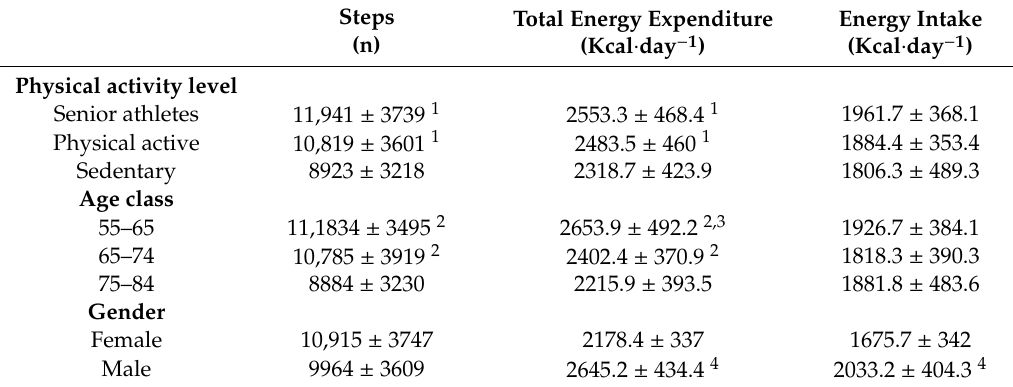
Table 2. Steps, total energy expenditure, and energy intake in relation to physical activity level, age class, and gender (mean ±